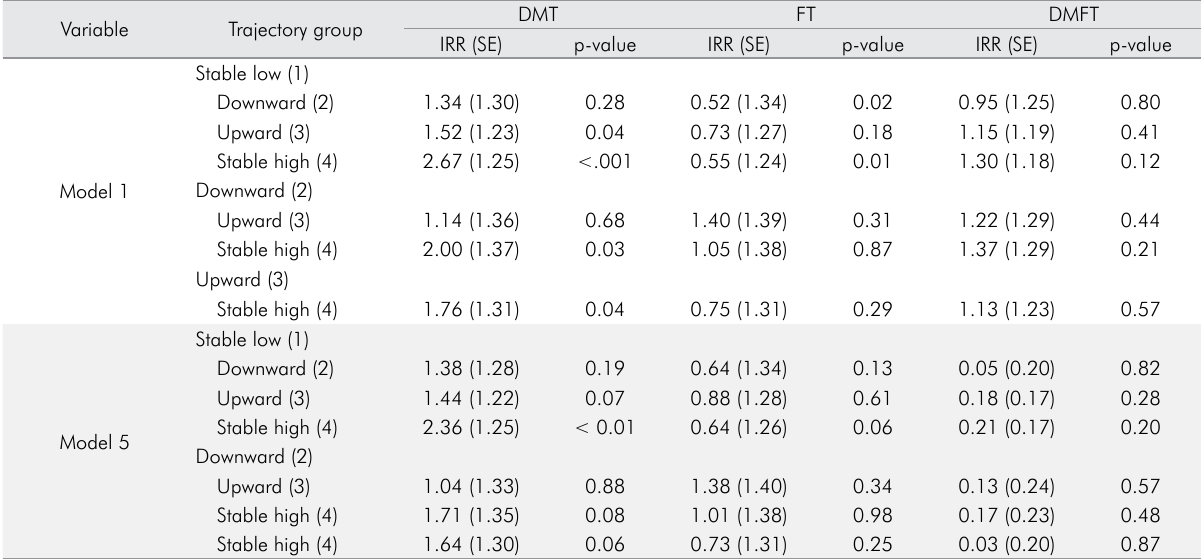
Table 3. Cross-reference between income trajectories.*